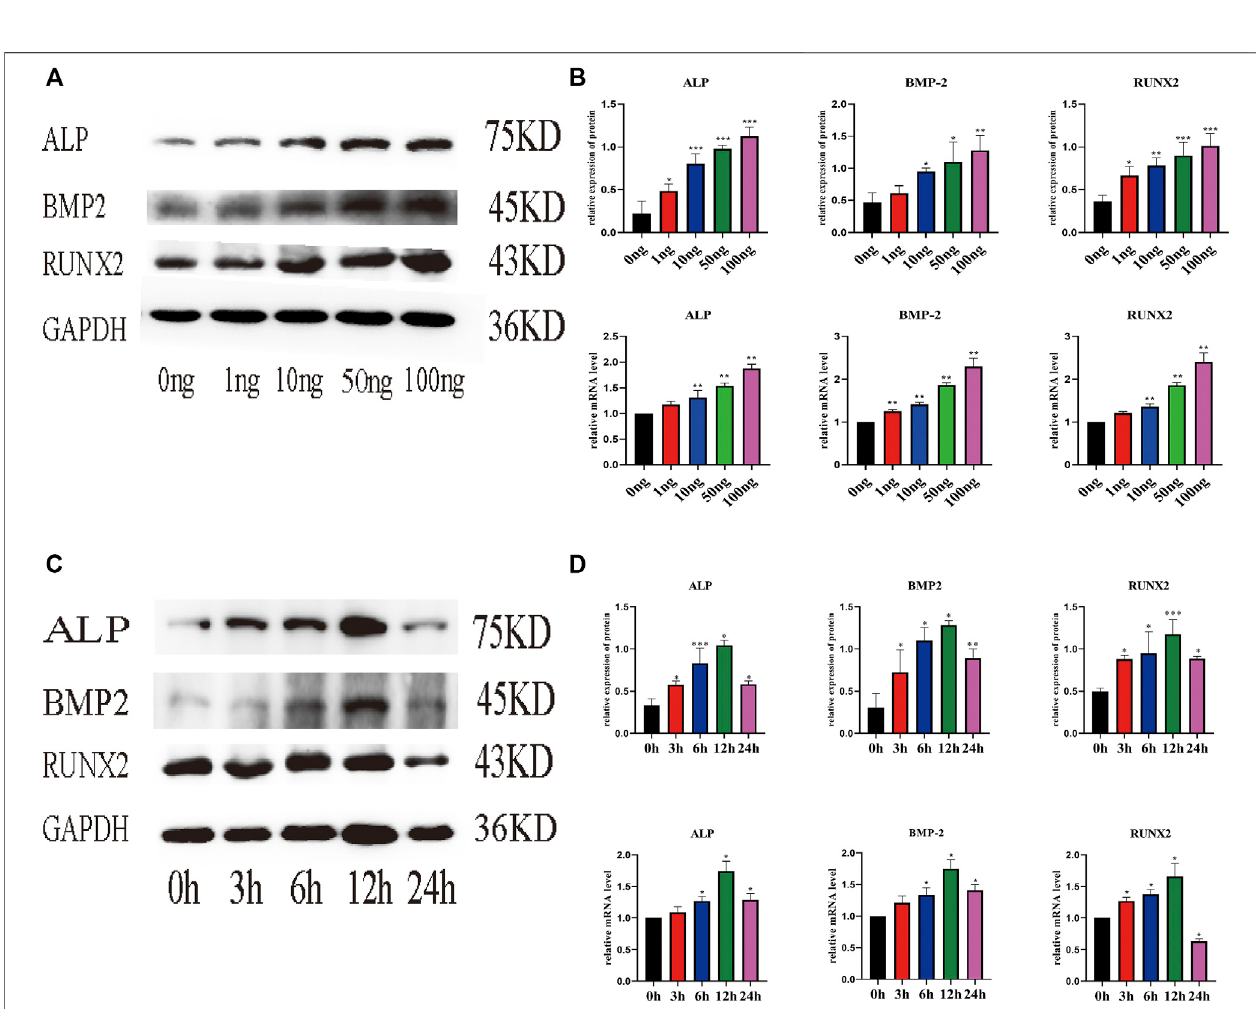
FIGURE 2 | IL-18 induced the expression of osteoblast-speci fi c markers in a dose- and time-dependent manner. hBMSCs were treated with different culture concentrations (0, 1, 10, 50, 100 ng) of IL-18, western blot and qPCR were used to evaluate the protein and mRNA (A, B) expression levels of ALP, BMP2, RUNX2, GAPDH. hBMSCs were treated with 100 ng/ml IL-18 for 0, 3, 6, 12 and 24 h, and Western Blotting and qPCR were used to evaluate the protein expression of osteoblast-speci fi c markers ALP, BMP2, RUNX2, GAPDH and their mRNA expression (C, D) . GAPDH was used as an internal control. Data are expressed as the mean ± standard deviation (SD). Concentration groups vs. the control (0 ng) group; time-point groups vs. the control (0 h) group, * p < 0.05, ** p < 0.01, *** p < 0.001.